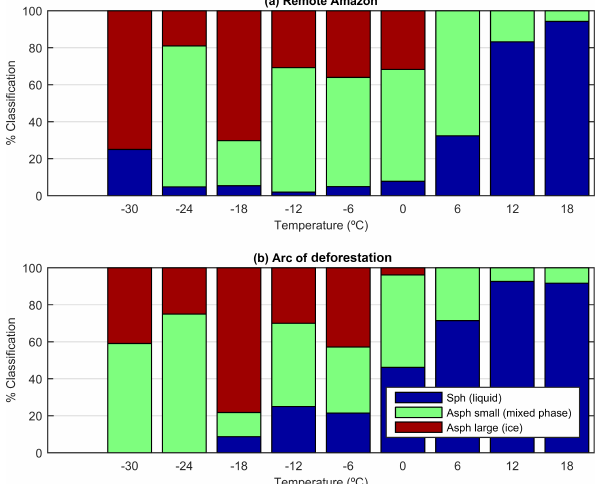
Figure 12. Frequency of occurrence of NIXE-CAPS spheric- ity classifications for (a) the remote Amazon and (b) the arc of deforestation. “Sph (liquid)” stands for many only spherical ( D < 0µm) and predominantly spherical ( D > 50µm) hydromete- ors, “Asph small (mixed phase)” for many predominantly spherical ( D < 50µm) and only aspherical ( D > 50µm) hydrometeors, and “Asph large (ice)” for only very few aspherical ( D < 50µm) and only aspherical ( D > 50µm) hydrometeors. Temperatures shown on the x axis are the center for 6 ◦ C intervals, which corresponds to roughly 1km thick